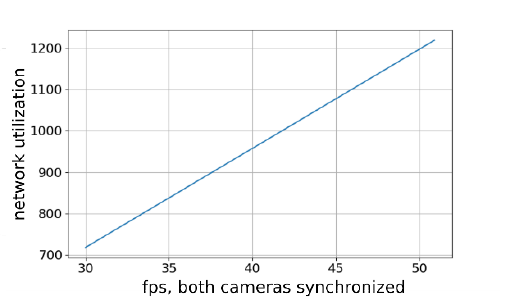
Figure 3. Network load depending on the framerate of the sensor system if RGB-Camera records FHD and the UV- Camera half the